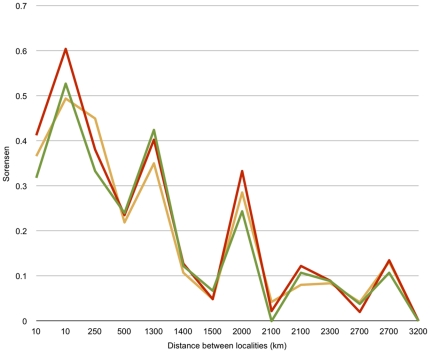
Relation between geographic distance and β-diversity (Sørensen index) for pairwise comparisons between localities.Sorensen index for species numbers based on morphology (green), numbers of cox1 clusters, estimated at 3% threshold of genetic DNA distance (red) and derived from GMYC algorithm (orange).